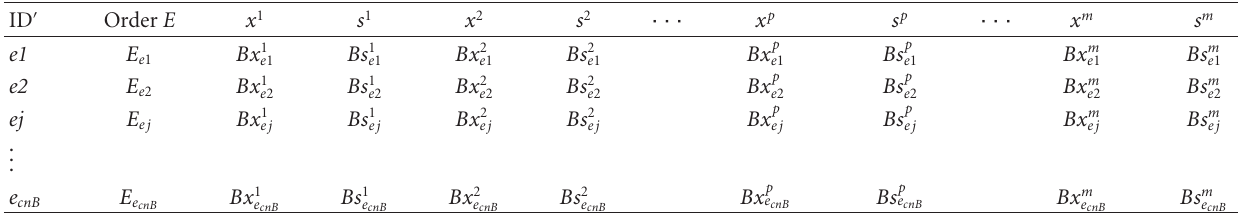
p ... , Bx m ej } , and ej ,